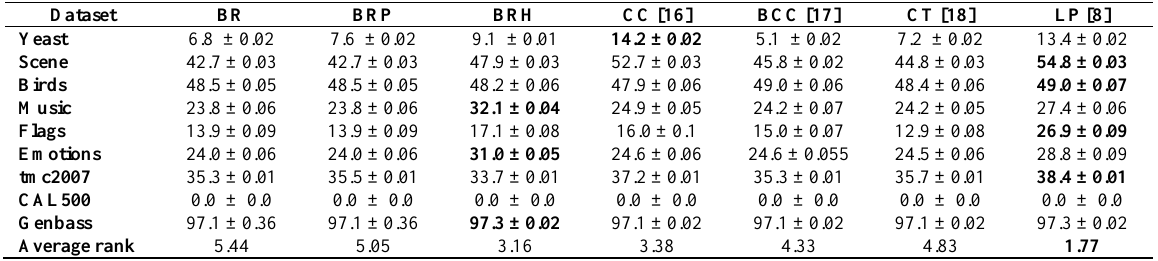
Table 4. Average and standard deviation of subset accuracy (exact match) of rival algorithms. Best results are shown boldface.